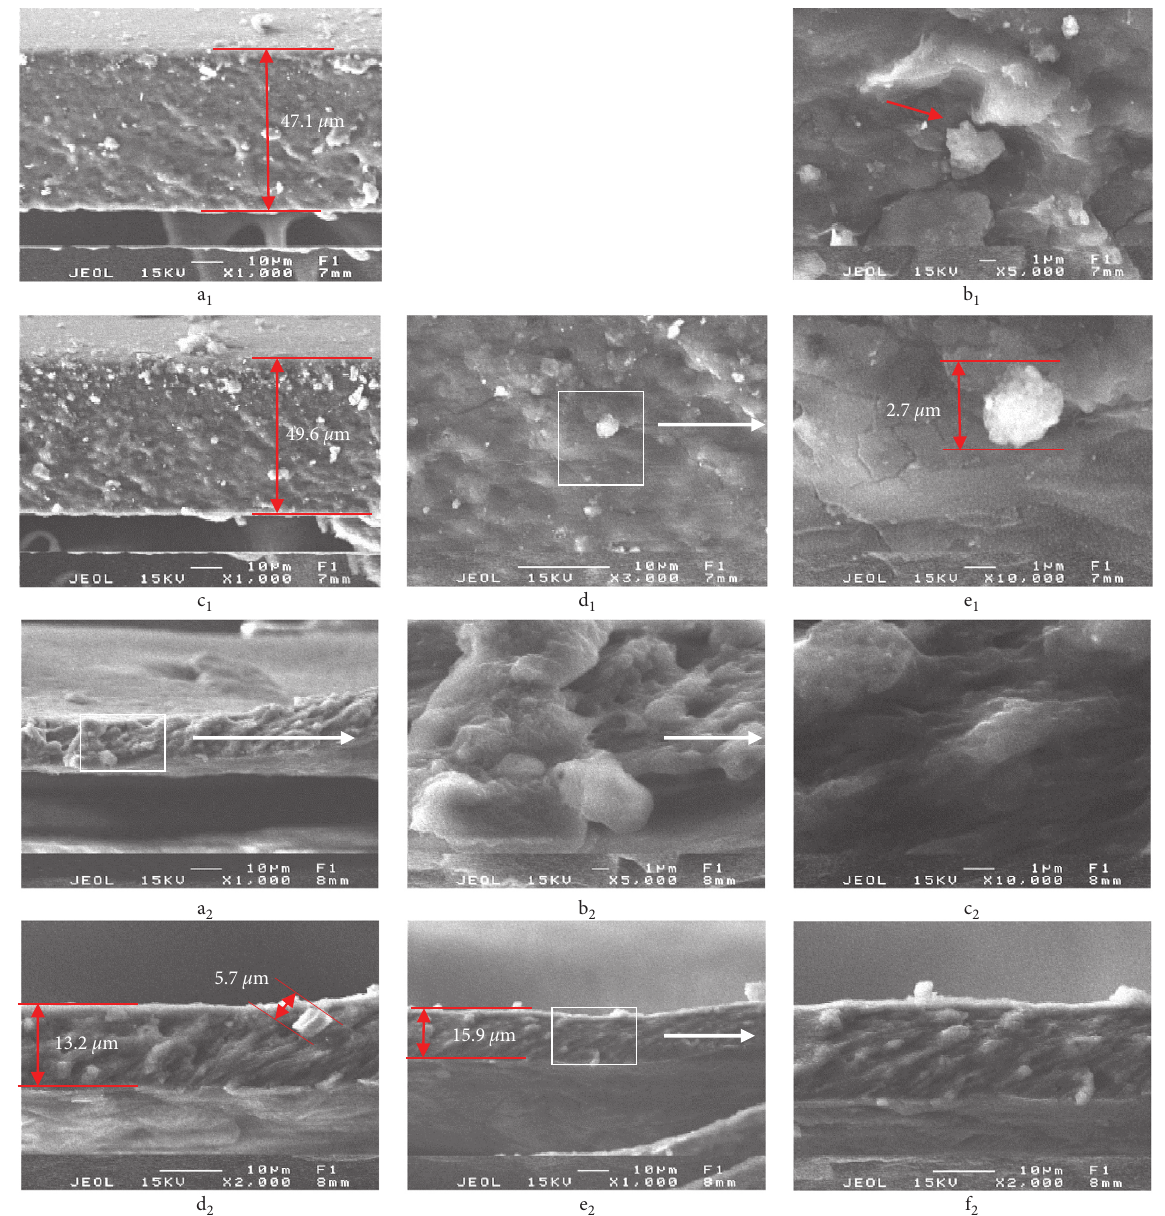
Figure 6: SEM images of cross-sections of the composite films containing CuNPs: (a White rectangles and arrows indicate magnified areas on the next